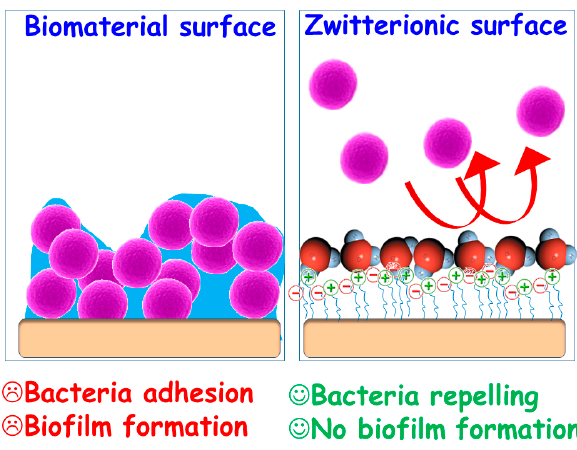
Figure 2. Schematic illustration of the different behavior of conventional biomaterial surfaces vs